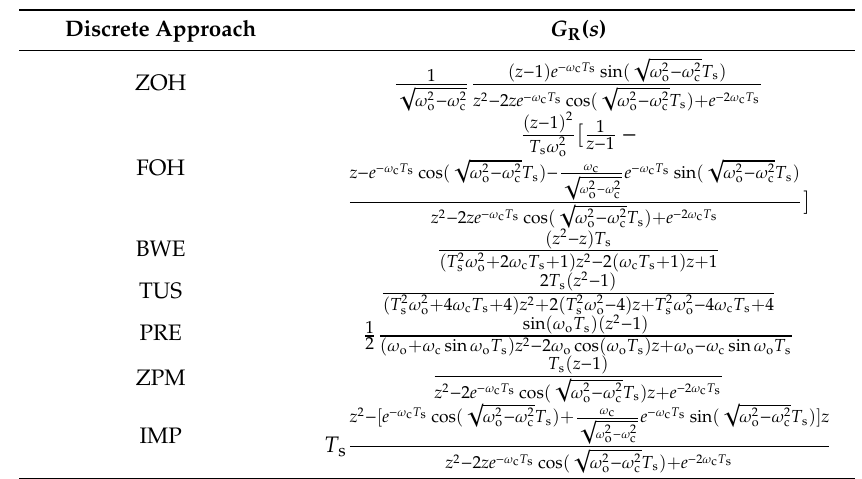
Table 1. Discrete method.